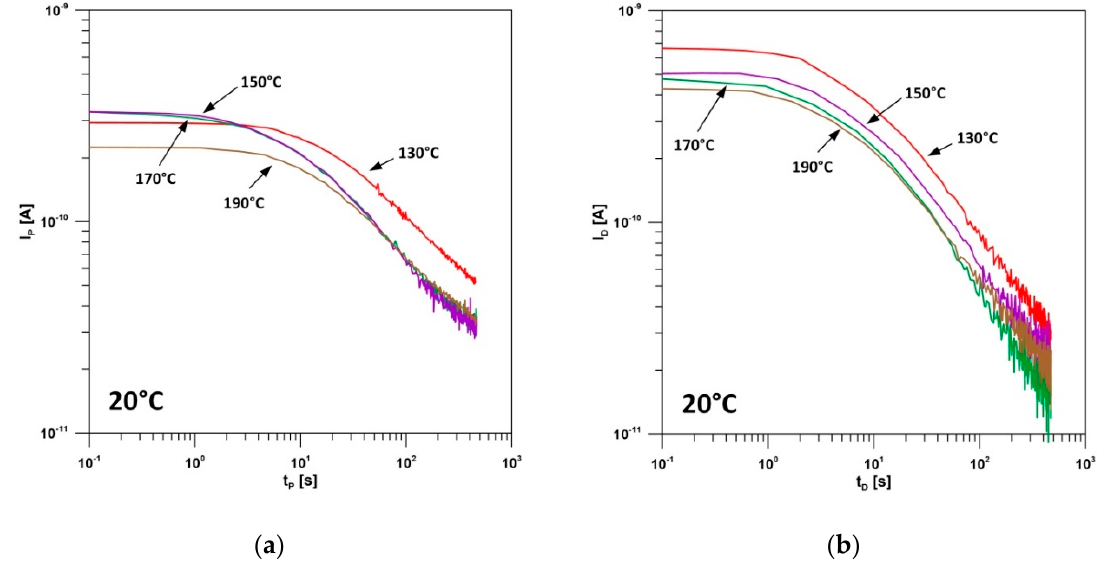
Figure 12. Characteristics of the polarization currents ( a ) and the depolarization currents ( b ) measured for unmoistened cellulose–aramid insulation samples for different degrees of initial ageing in the measurement temperature 20 °C.